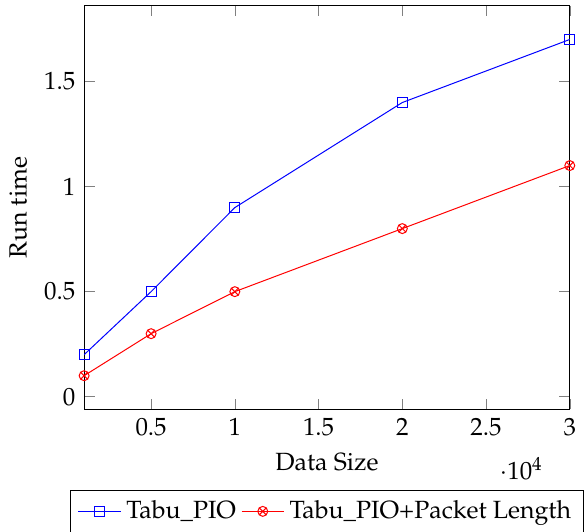
Figure 8. Run-time for our